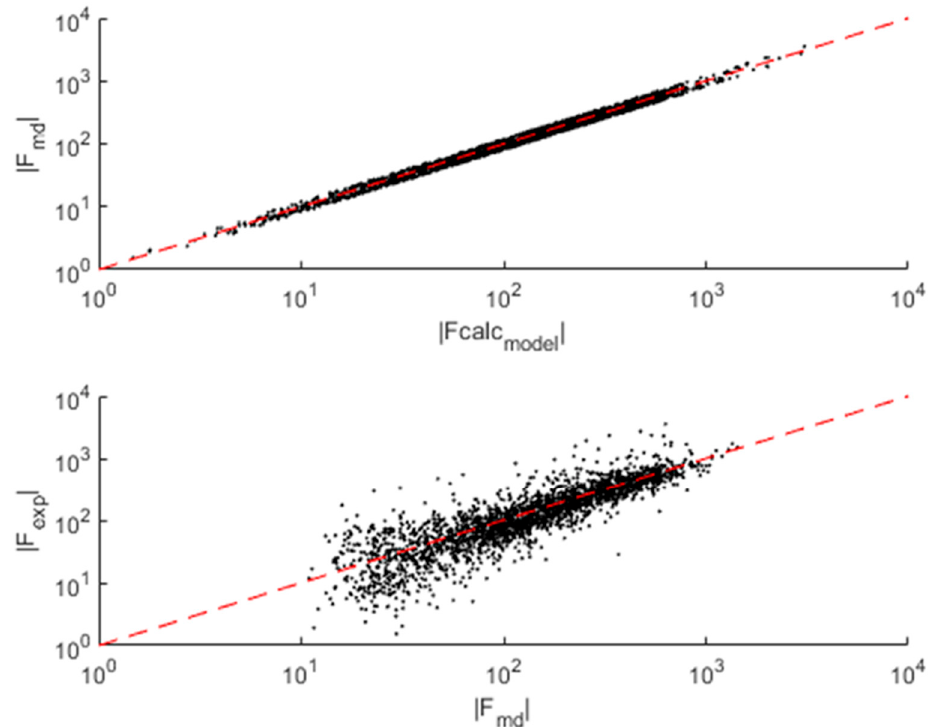
Figure 2. F calc /F md and F md /F exp plots for the Hyp-1 protein structure. The maximal permissible relative error between reflections with identical indices was established at a level of 20%. The red dashed line at 45° should serve as a guide to the eye and tool to visualize trends in changes of reflection intensity.